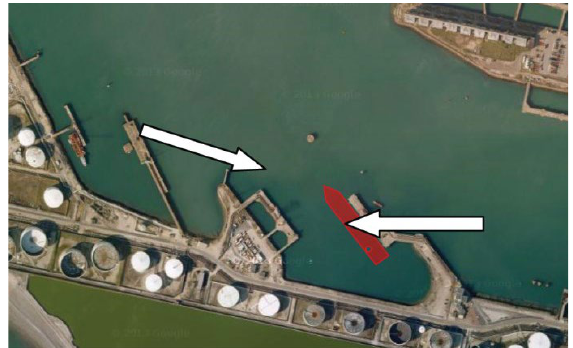
Fig. 3. Jetties for the oil terminal at the Port of Le-Havre and directions of tidal currents